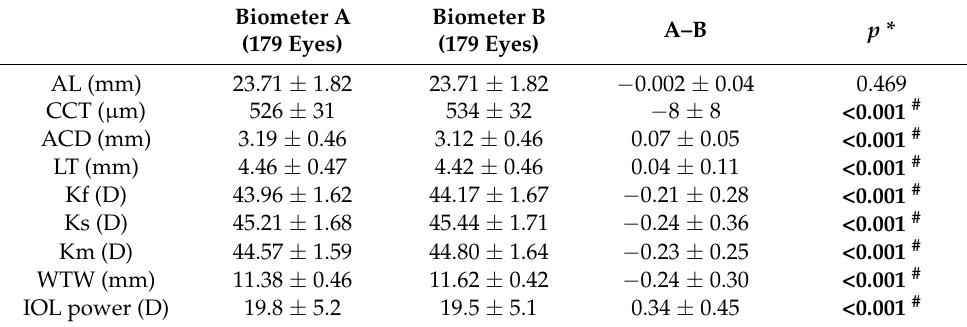
Table 2. Anterior segment parameters in both devices.